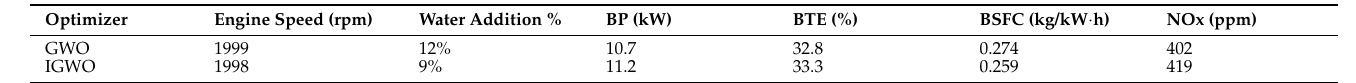
Table 6. Results of optimization for each response in relation to engine speed and water addition